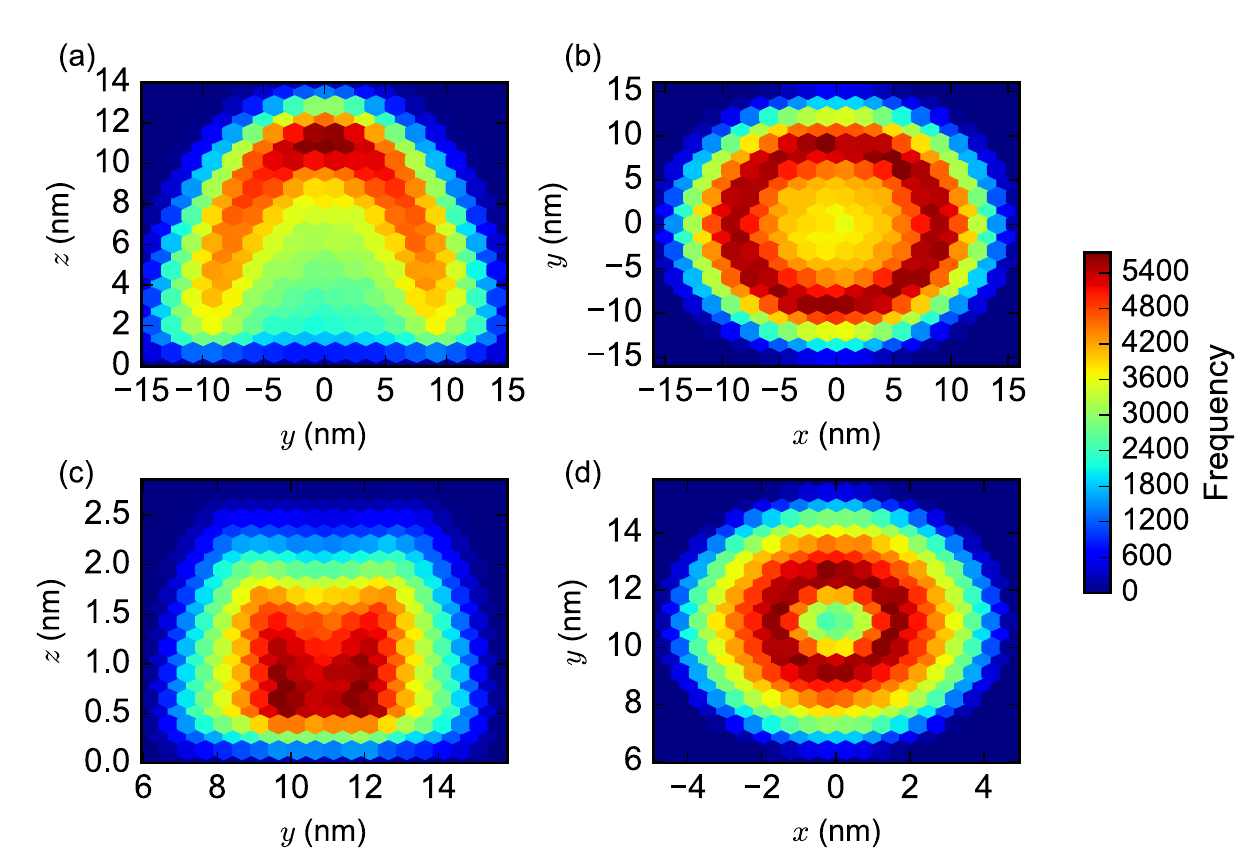
Figure 4. 2-dimensional heat maps of the reactive point of 10 6 samples of the H 0 and H 1 structures generated using the WN model. ( a ) ( y , z ) projection of reactive point of H 0 structures into the x = 0 plane. ( b ) ( x , y ) projection of H 0 structures into the z = 0 plane. ( c ) Similar ( y , z ) projection of H 1 structures. ( d ) Similar ( x , y ) projection of H 1 structures. See Fig. 1 for the directions of the x , y , and z